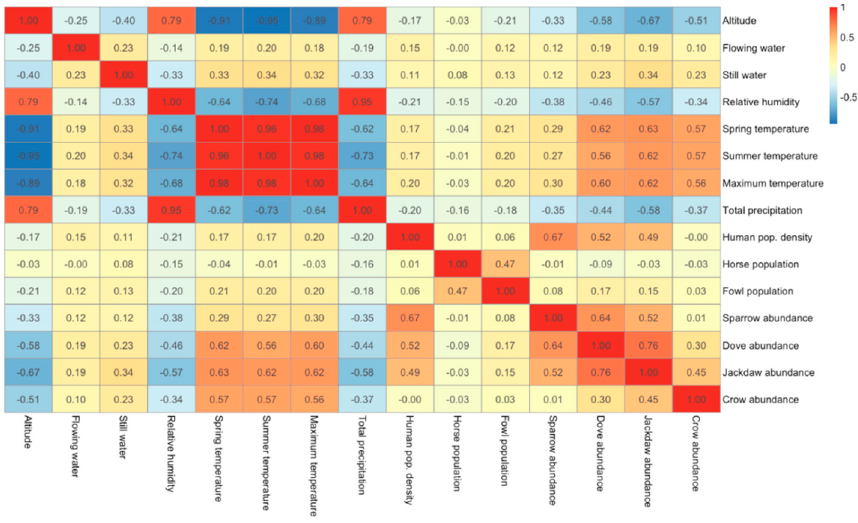
Figure 7. Spearman’s rank correlation coefficient between the biotic and abiotic predictors.